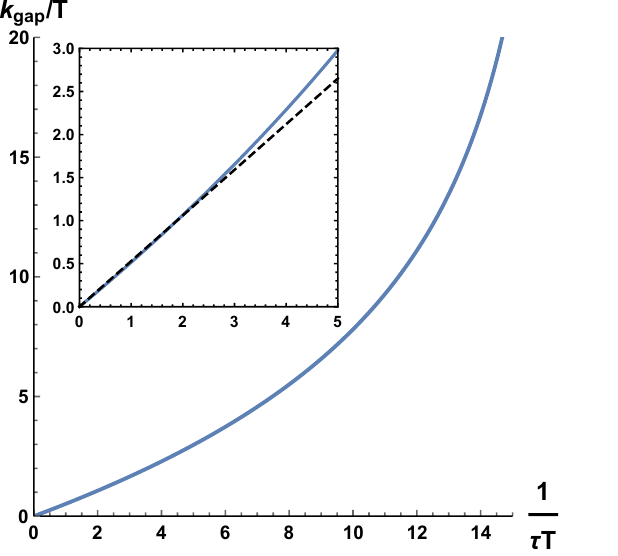
Figure 6 . The dimensionless k gap (3.9) in function of the dimensionless inverse relaxation time 1 =T(cid:28) for a large cuto(cid:11) value ~ M = 1000. The inset shows the linear relation for small values of those